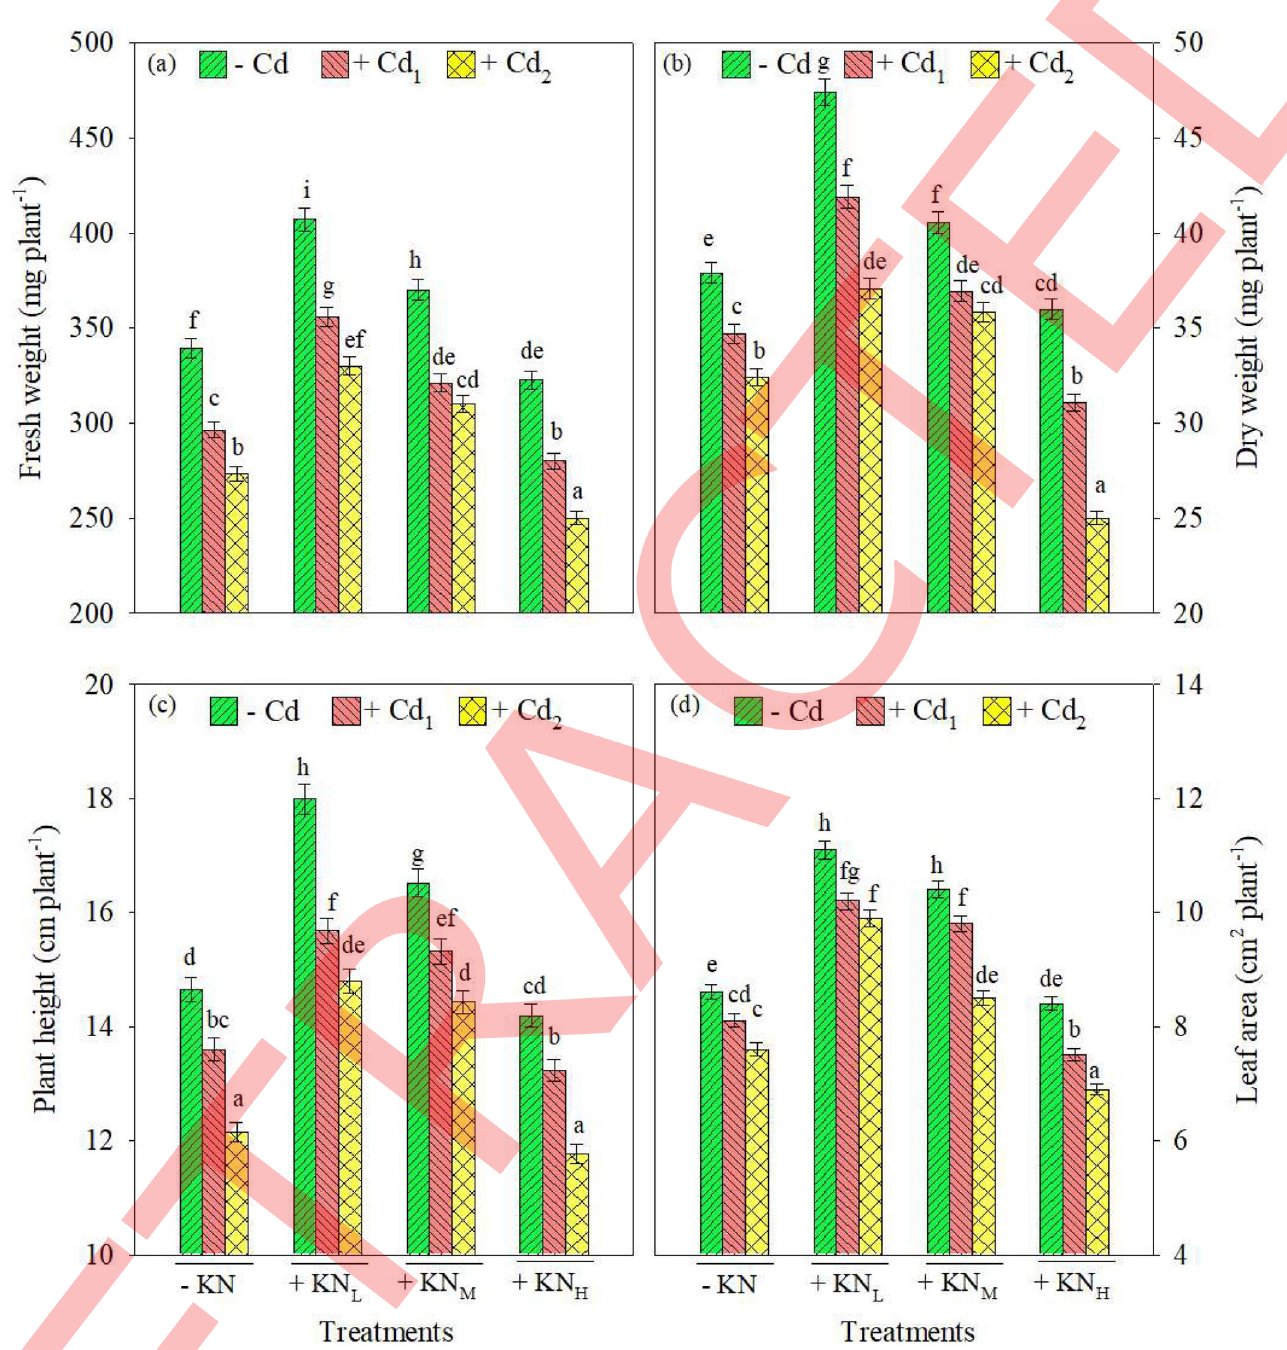
Fig 1. Impact of foliar application of kinetin on growth attributes of Trigonella seedlings exposed to Cd stress. Data represent the mean value ± standard error from three replicates (n = 3). Values followed by the different letters at each bar differ at P < 0.05 among treatments by the DMRT.